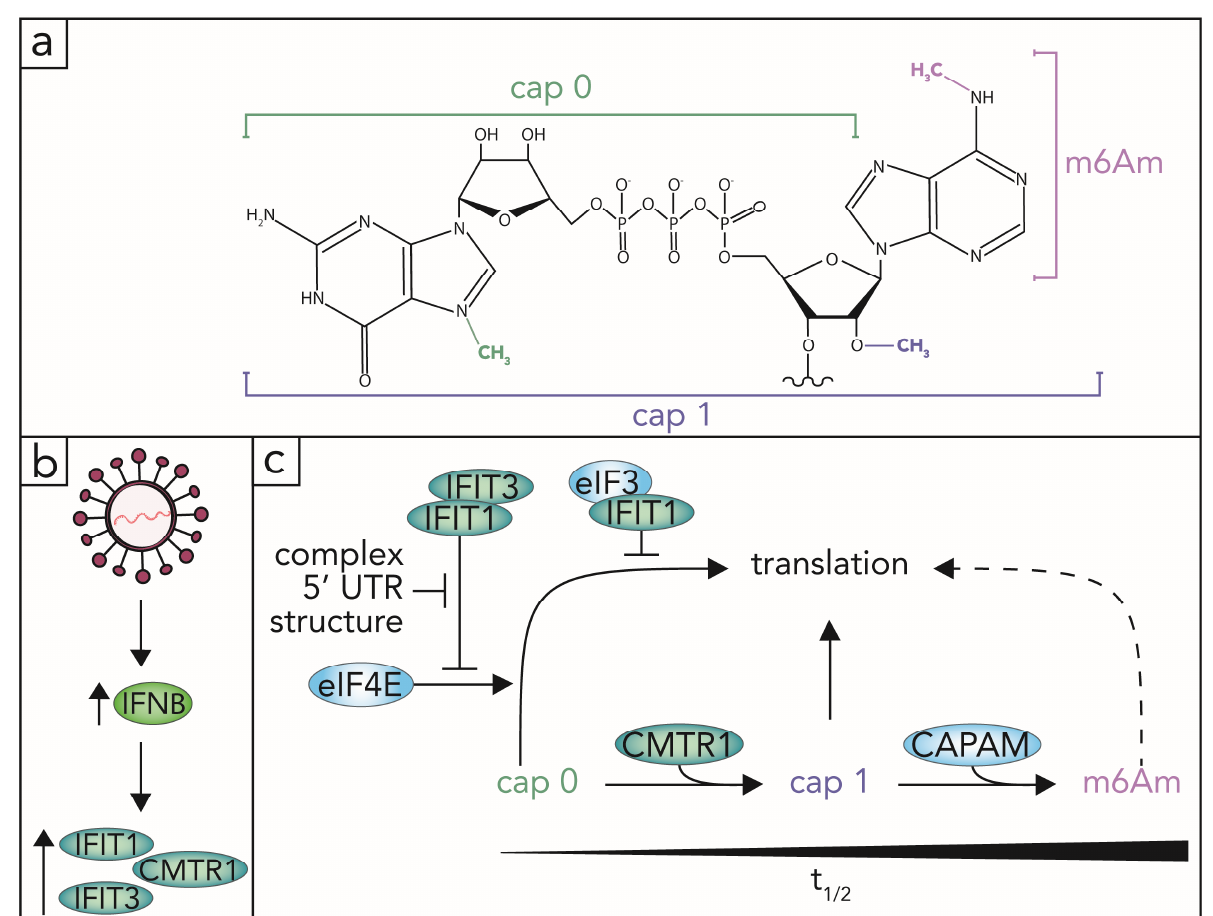
Figure 4. Cap modifications impact protein binding on an mRNA, thus affecting its ultimate fate. ( a ) The 7-methylguanosine cap (m7G) cap 0 structure is composed of an inverted guanosine residue that is methylated at the N7 position (green) and connected to the first transcribed base by a triphosphorylated linkage. A methylation at the 2′ hydroxyl on the ribose sugar of the first transcribed base (blue) forms the cap 1 structure. A large proportion of eukaryotic mRNA also contains a methyl-6-adenosine (m6A) residue as the first transcribed cap 1 base, denoted as 2′O-dimethyladenosine (m6Am, purple). ( b ) Upon infection with a virus, the interferon beta (IFNB) pathway is induced, resulting in the upregulation of Cap methyltransferase 1 (CMTR1) and the expression of Interferon induced protein with tetratricopeptide repeats (IFITs)- 1 and 3. ( c ) The cap 1 modification, which is co-transcriptionally added by CMTR1, is efficiently translated and bypasses IFIT1-mediated translational restriction. IFIT1 restricts translation by sequestering RNA from Eukaryotic initiation factor 4 E (eIF4E). This restriction is enhanced by heterodimerization of IFIT1 with IFIT3. A predicted stem loop structure on the 5′ UTR of cap 0 transcripts was shown to overcome translational restriction via IFIT1 [25] . IFIT1 also prevents translation through protein-protein interactions with eIF3. Whether the m6Am modification increases, decreases, or has no effect on translation is unclear, as denoted by the dashed line. However, the m6Am modification has been associated with an increase in transcript stability, as denoted by the longer half-life (t 1/2 ) whereas the cap 0 modification is associated with a decrease in transcript stability.